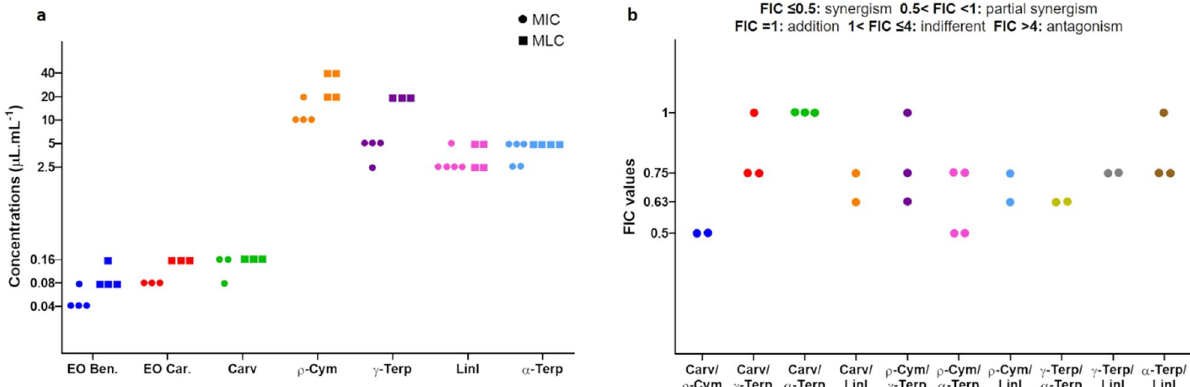
Figure 1. Antimicrobial activity of two EOs from Thymbra capitata , carvacrol, ρ-cymene, γ-terpinene, linalool, and α-terpinene against Gardnerella sp. UM241. ( a ) Determination of the minimum inhibitory and minimum lethal concentration. ( b ) Results from checkerboard assays of combinations between the selected individual compounds from the EO. Individual points represent distinct checkerboard combinations. In both panels, each point represents the results from independent